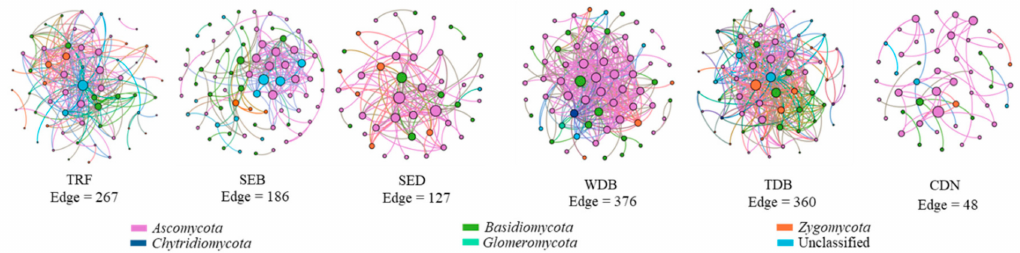
Figure 7. Network co-occurrence analysis of soil fungal communities in six forest types along a latitudinal gradient. Nodes are labeled at the phylum level. The correlations between operational taxonomic units (OTUs) are represented by edges that connect these